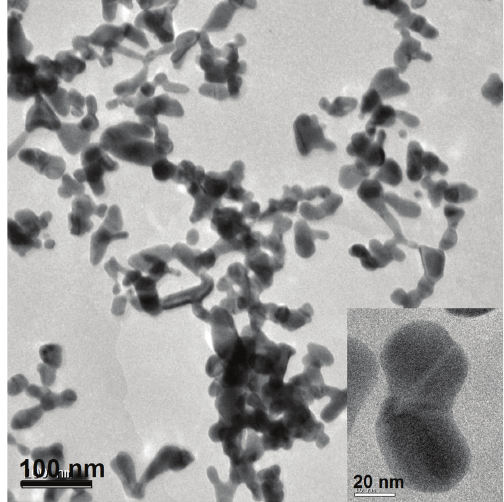
Figure 4: Transmission electron microscopy of PVP stabilized AuNPs synthesized by TPB act as reductant; Inset. Higher magni- fication of PVP stabilized